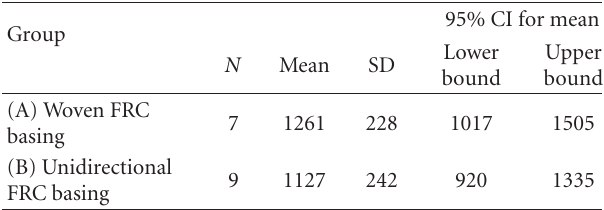
Table 2: Fracture loads of repaired specimens in newton. ∗